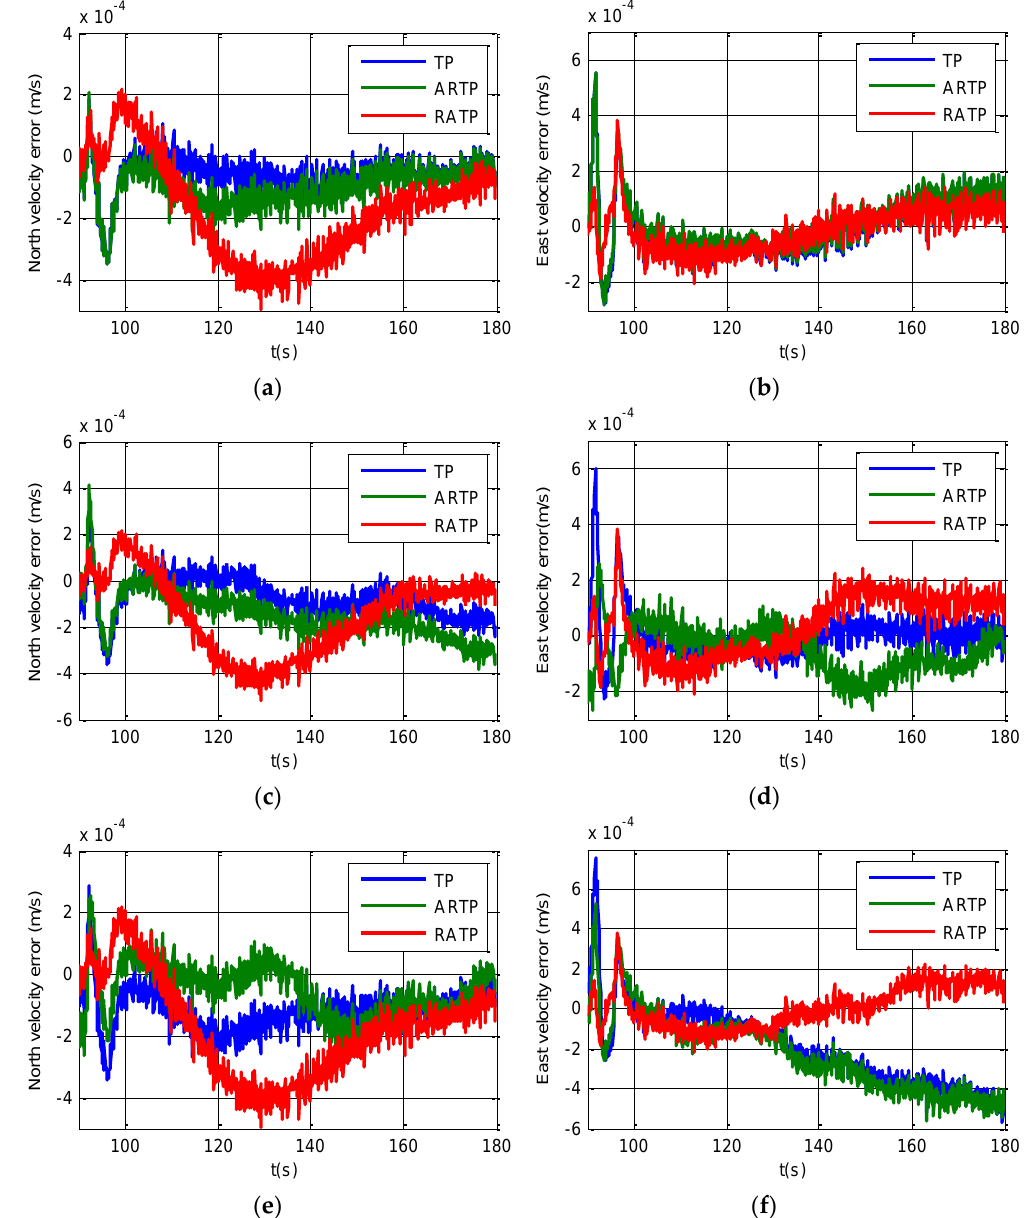
Figure 5. Velocity curves under different conditions from 90 to 180 s. ( a ) North velocity error under stationary condition; ( b ) East velocity error under stationary condition; ( c ) North velocity error under angular vibrations with an amplitude of about 5 arcsec and a random frequency between 5 and 10 Hz; ( d ) East velocity error under angular vibrations with an amplitude of about 5 arcsec and a random frequency between 5 and 10 Hz; ( e ) North velocity error under angular vibrations with an amplitude of about 10 arcsec and a random frequency between 5 and 10 Hz; ( f ) East velocity error under angular vibrations with an amplitude of about 10 arcsec and a random frequency between 5 and 10 Hz.